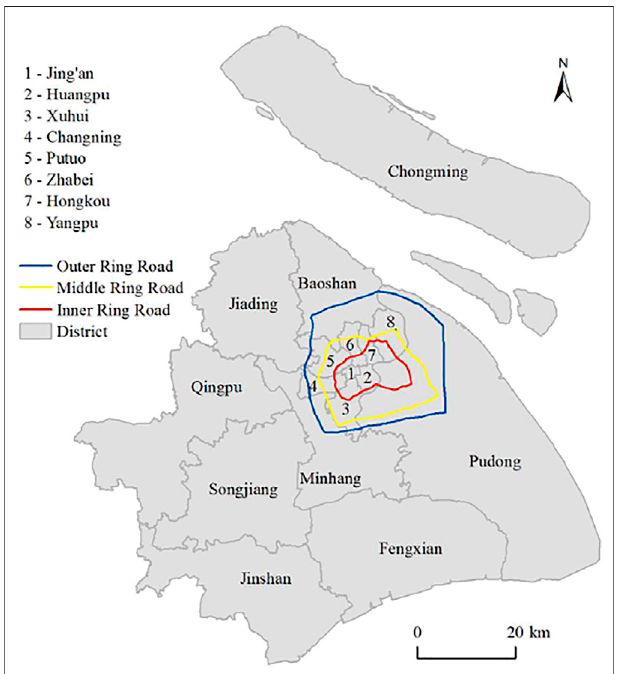
FIGURE 1 | The division of Shanghai at district level.